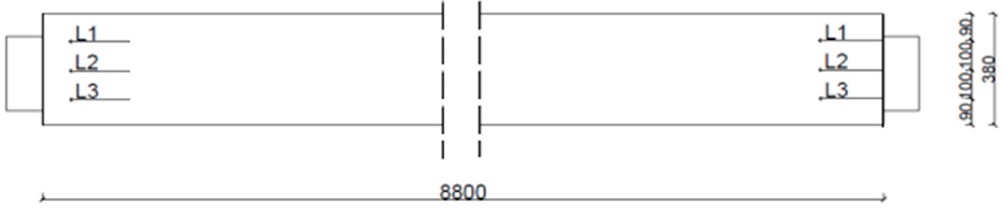
Figure 2. Diagram of measuring lines L1, L2, L3.